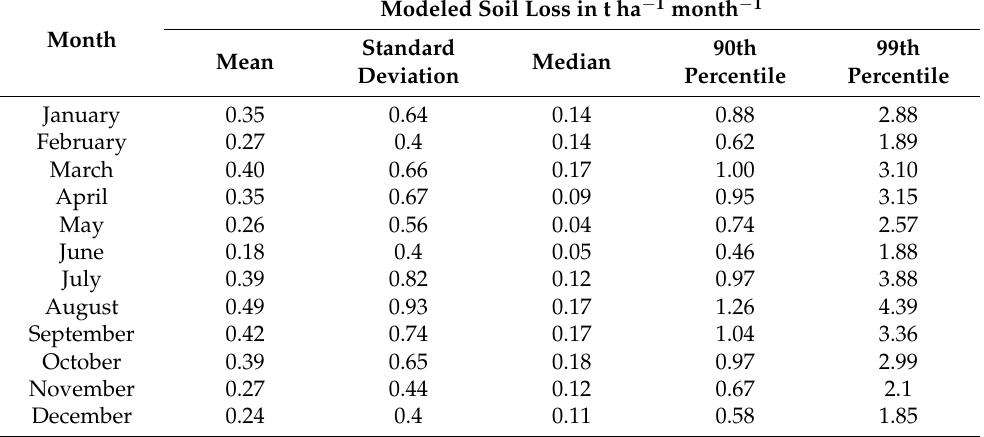
Table 4. Statistical parameters of the modeled monthly soil loss in t ha − 1 month − 1 by the revised wind erosion